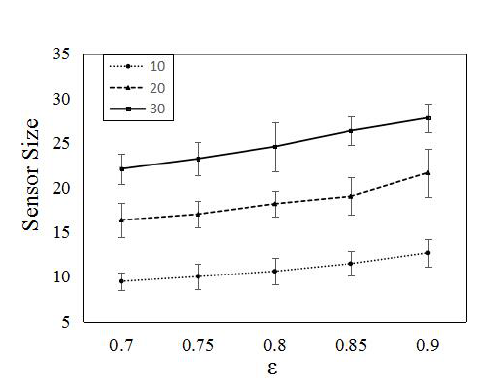
Figure 9. Comparing the numbers of active sensors for different target sizes and detection probability threshold in a 100 m × 100 m area. We randomly deployed 120 sensors in the area and set the minimum detection probability p min = 0.2. The numbers of targets are 10, 20, 30.